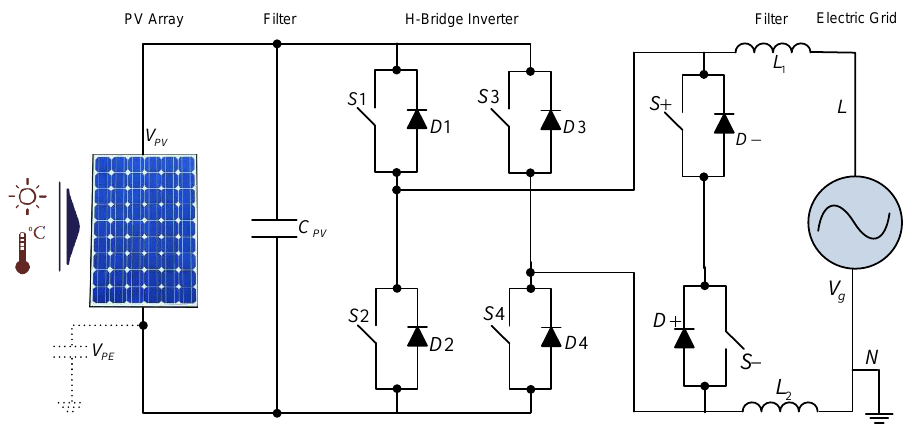
Figure 9. Schematic diagram of the Sunways HERIC Inverter [43,56].